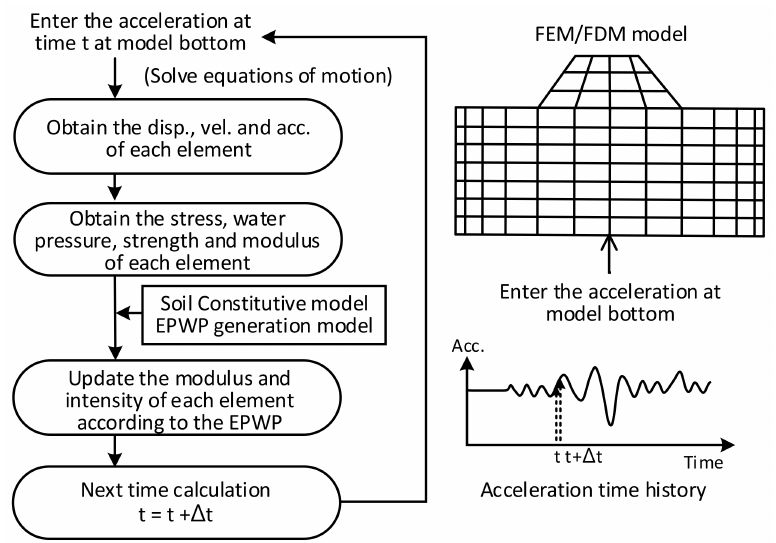
Figure 9. The concept of the dynamic effective stress method